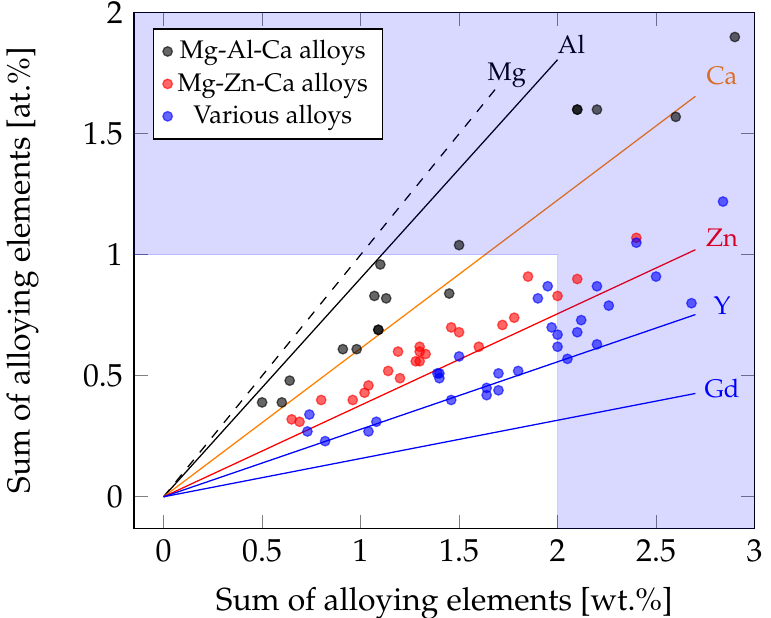
Figure 1. Effect of alloying elements and content on the alloys discussed in this work (limits of ~1 at.% and ~2 wt.%). Dots mark individual alloys, while lines show the trend of binary Mg alloys with the indicated